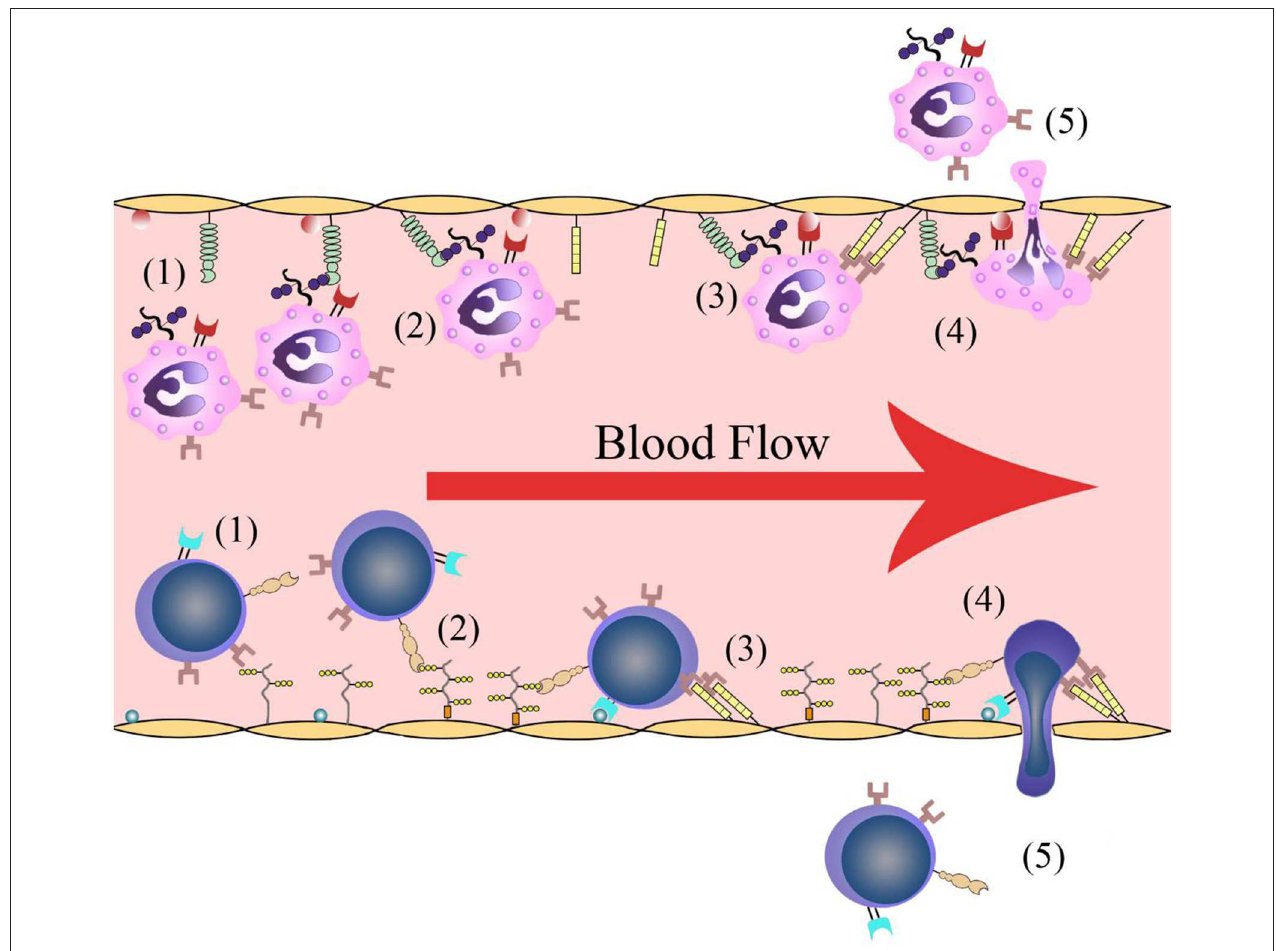
FIGURE 1 | Leukocyte infiltration process. (1) Leukocytes roll along the vascular endothelium. (2) Leukocytes are recognized and initially bind to the blood vessel walls. (3) Leukocyte activation and leukocyte-endothelial cell adhesion. (4) Leukocytes travel through the vascular wall. (5) Leukocytes transmigrate into the ischemic